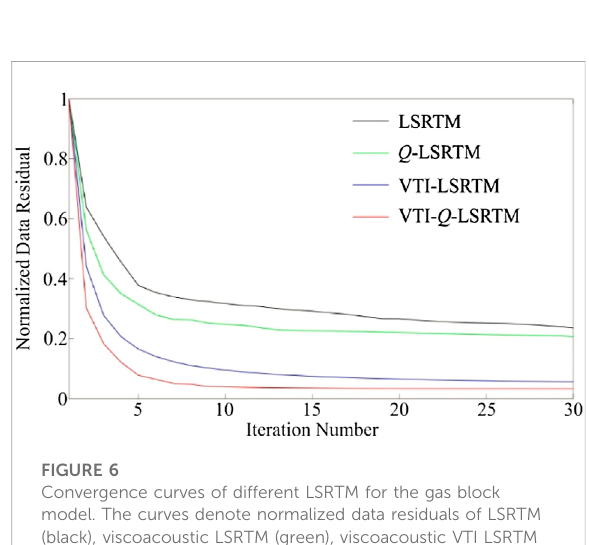
FIGURE 5 ComparisonofwaveformsextractedfromFigure4,whichare in the range of x=1.8 km, z = [1.5, 2.1] km. The curves denote waveforms of LSRTM (black), viscoacoustic LSRTM (green), viscoacousticVTILSRTM(blue),andviscoacousticVTILSRTM (red), respectively.